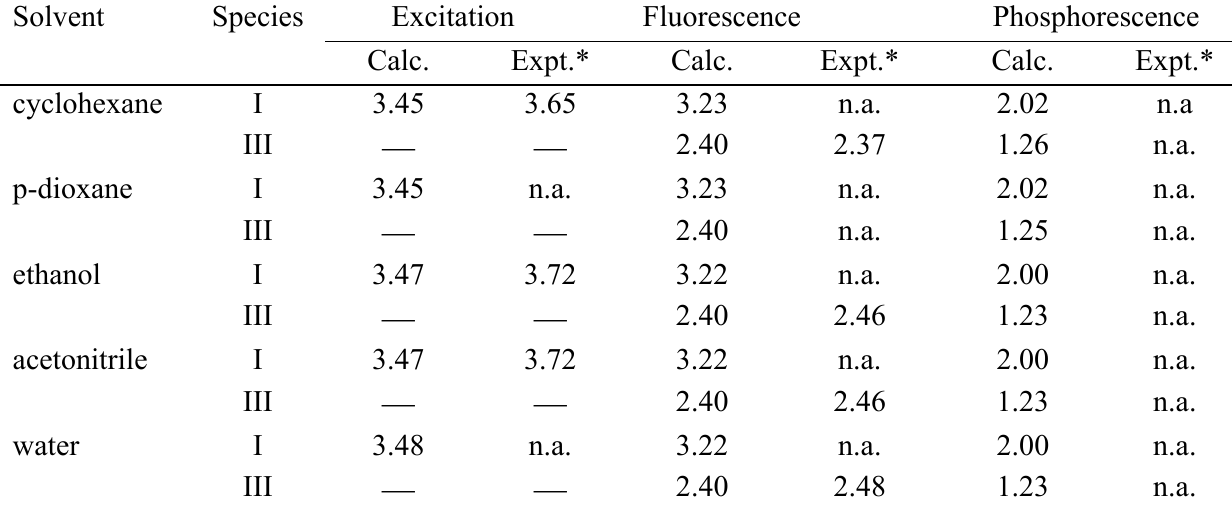
Table 14. Assignment of excitation, fluorescence and phosphorescence spectra of HPT in different solvents in terms of calculated energies (eV). Numbers within parentheses refer to the references corresponding to the experimental data. (n.a. indicates non-availability of